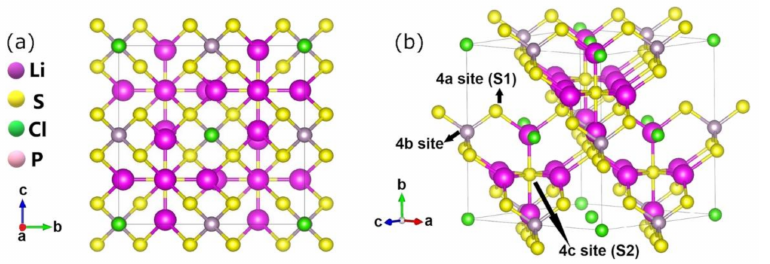
Figure 1. Sample of Li 6 PS 5 Cl lattice structure. Purple = lithium, yellow = S, green = Cl, and light purple = P atoms (at the middle of the PS 3 − ion). Adapted from Baktash et al. 4